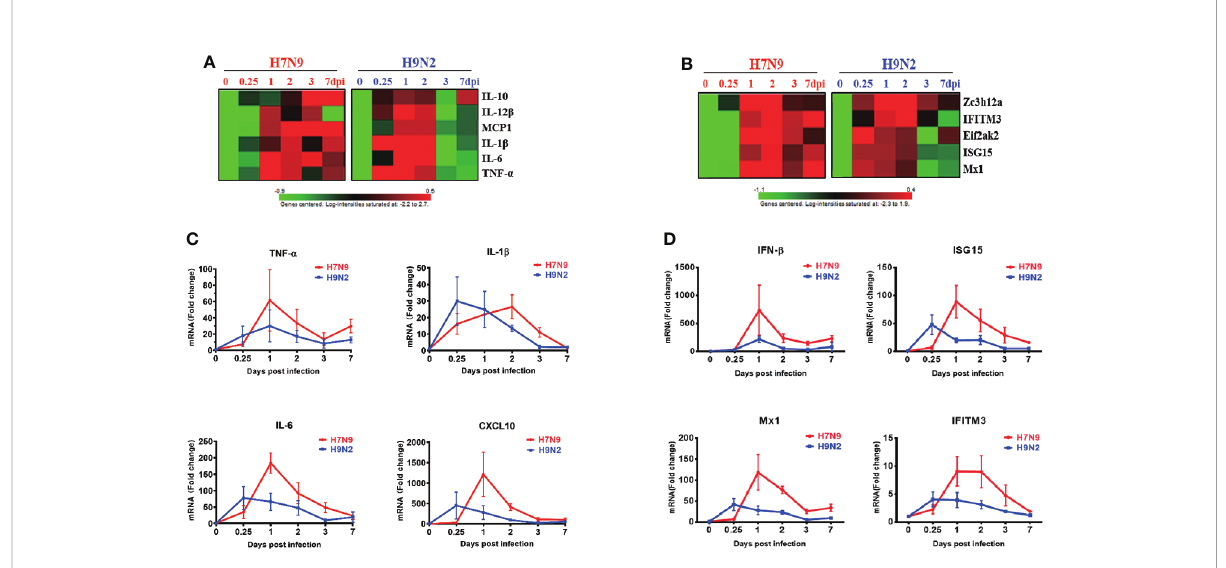
FIGURE 2 Comparative analysis of gene expression dynamics in the lungs of infected mice. Total RNA of lung tissues harvested at 0,0.25,1,2,3,7 dpi from H7N9- or H9N2-infected mice were subjected to microarray-based transcriptome analysis. The microarray data were used for analyzing the expression of proin fl ammatory cytokines and anti-viral ISGs, expressed as heatmaps of relative gene expression after normalization to the value of mock-infected mice (A, B) . Real-time RT-PCR was performed to validate the microarray analysis (n=3 per time point), with the results shown respectively for cytokines (C) and anti-viral ISGs (D)